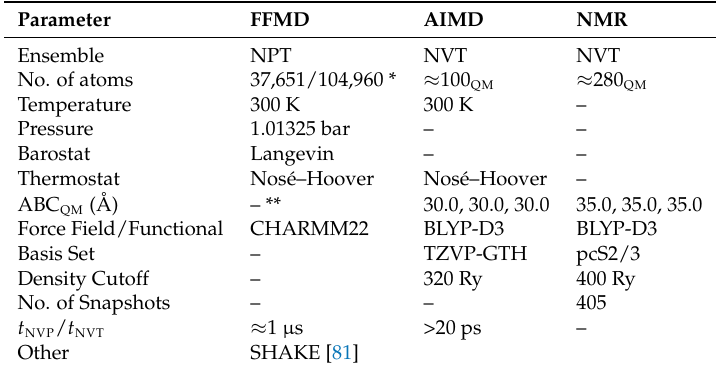
Table 3. Computational details of force field and ab initio molecular dynamics calculations for the protein study.